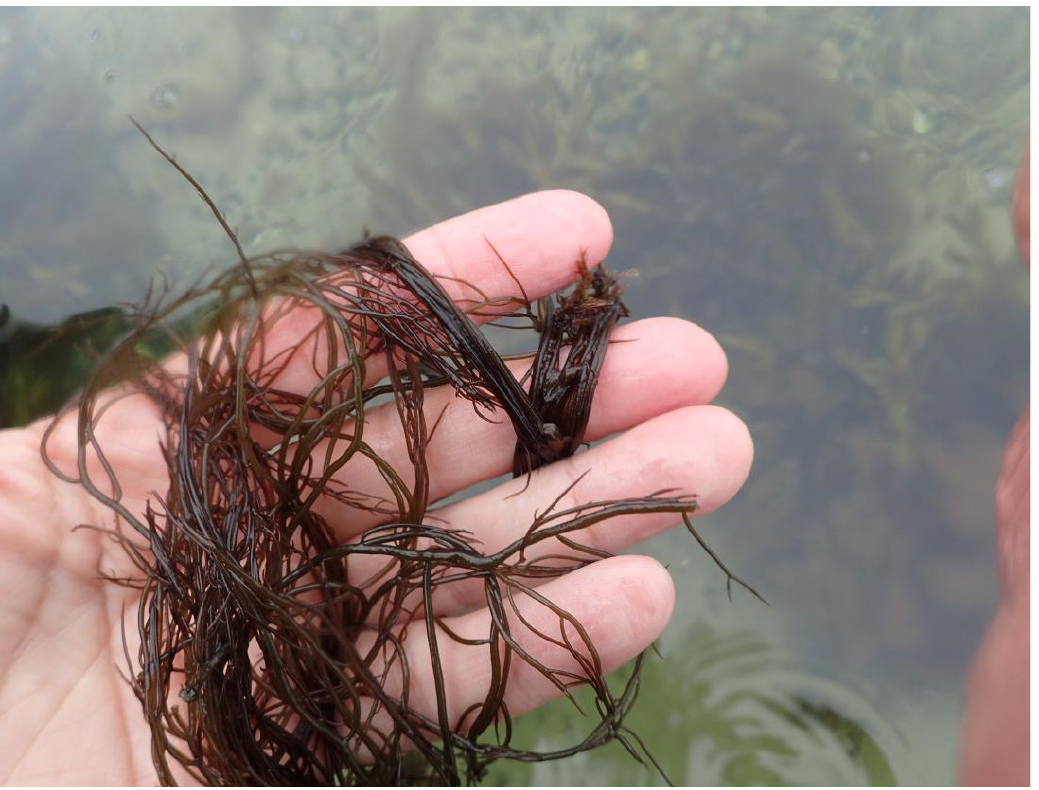
Figure 18. Gracilaria vermiculophylla sampled from Begtrup Vig, Denmark (20th of September 2020). Photo by Karen-Lise Krabbe.